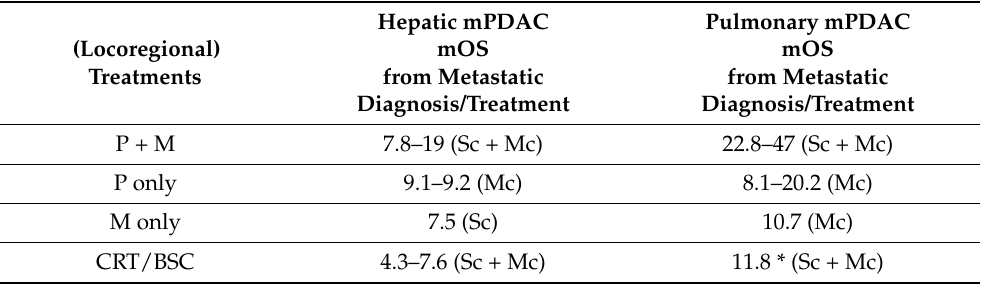
Table 7. Survival outcomes per treatment group: no (CRT, BSC), single (P or M) or double (P + M) local treatments. mOS = median overall survival; P = local primary pancreatic treatment; M = local metastatic treatment; CRT = chemo(radio)therapy; BSC = best supportive care; Sc = synchronous; Mc = metachronous. * Data from Liu et al. [66], not included in the articles selected for this systematic